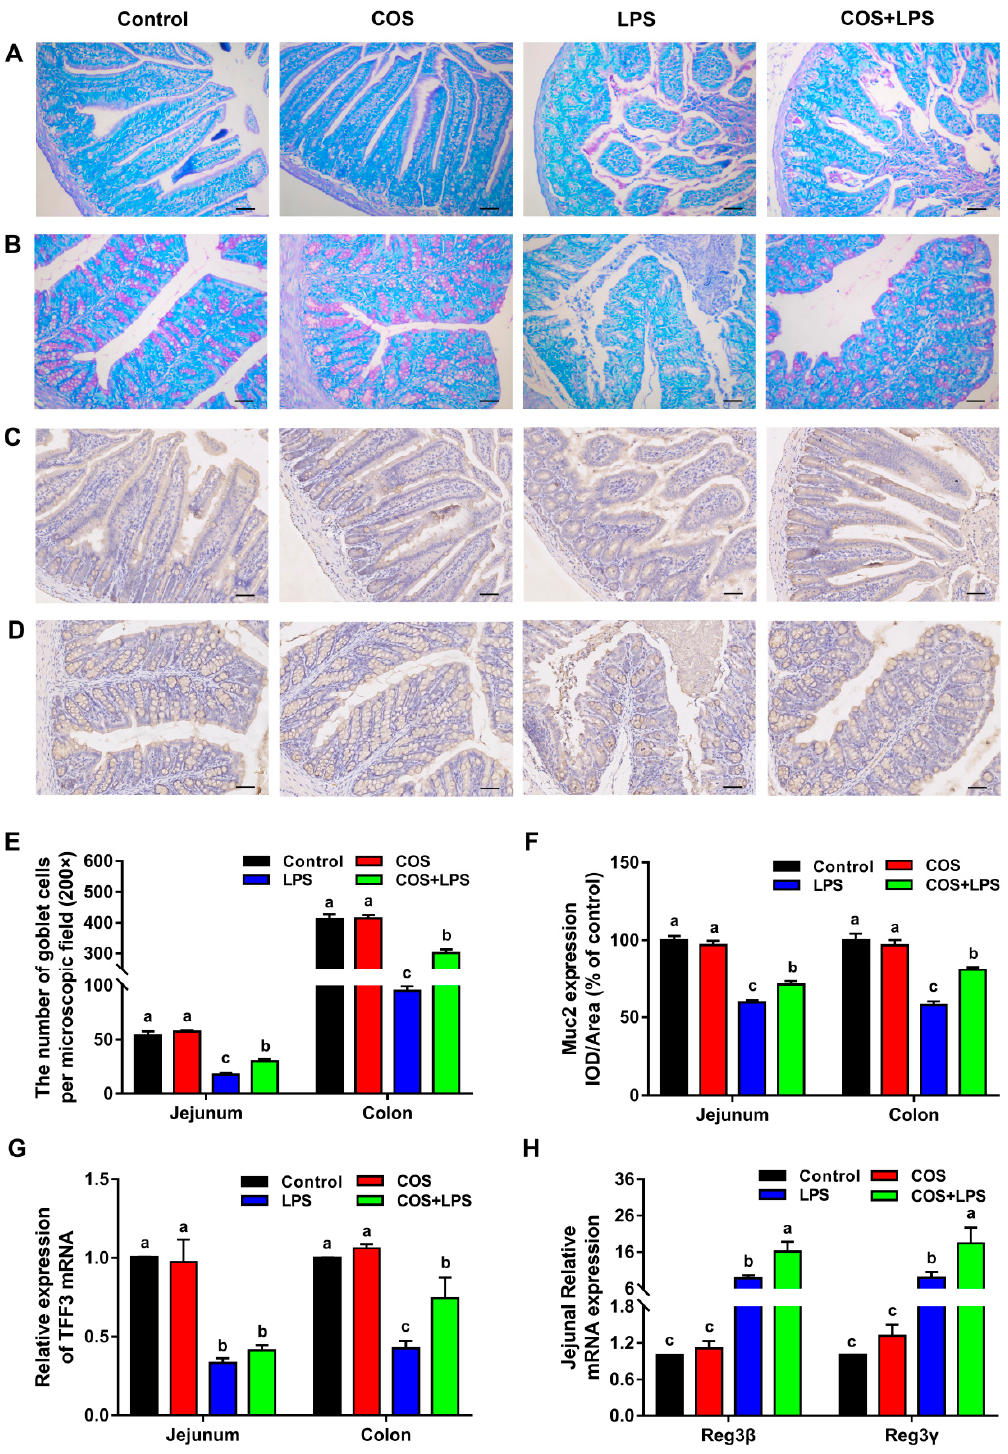
Figure 5. Effects of COS on biochemical barrier function of the jejunum and colon in mice. Representative images of the jejunum ( A ) and colon ( B ) stained with PAS, scale bar = 50 µ m. Representative immunohistochemical staining of Muc2 in the jejunum ( C ) and colon ( D ). ( E ) The number of goblet cells per microscopic field. ( F ) The IOD/area of Muc2. ( G ) The relative mRNA expression of TFF3 in the jejunum and colon. ( H ) The relative mRNA expressions of Reg3 β and Reg3 γ in the jejunum. The data are presented as the mean ± SE ( n = 6). Values without a common letter are significantly different ( p < 0.05). COS, chitosan oligosaccharide; LPS, Lipopolysaccharide; Muc2, mucin-2; TFF3, trefoil factor family 3; and Reg3, regenerating gene type III.